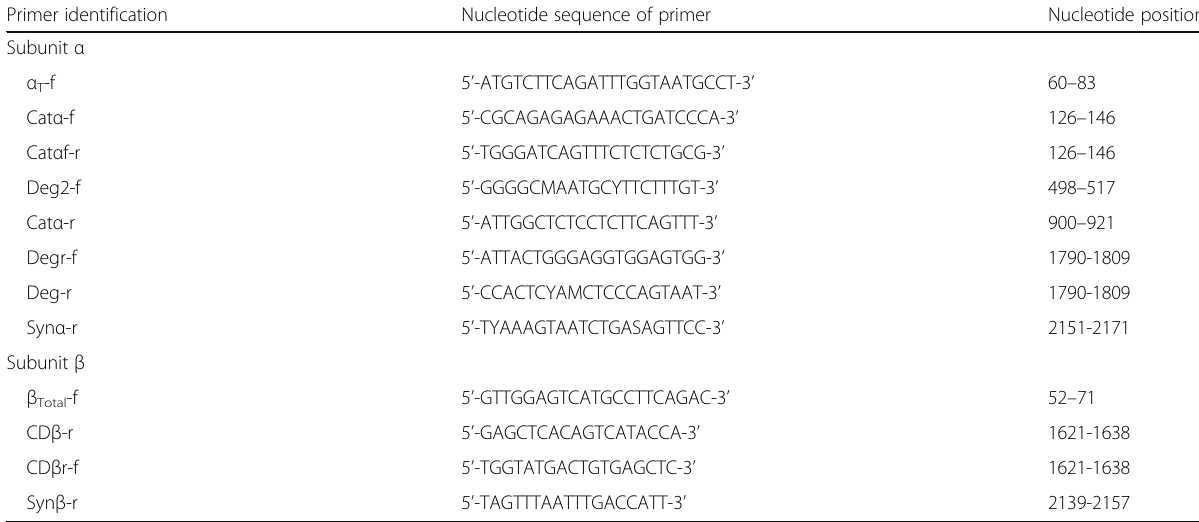
Table 1 Nucleotide sequences of primers used for RT-PCR and cloning experiments Primer